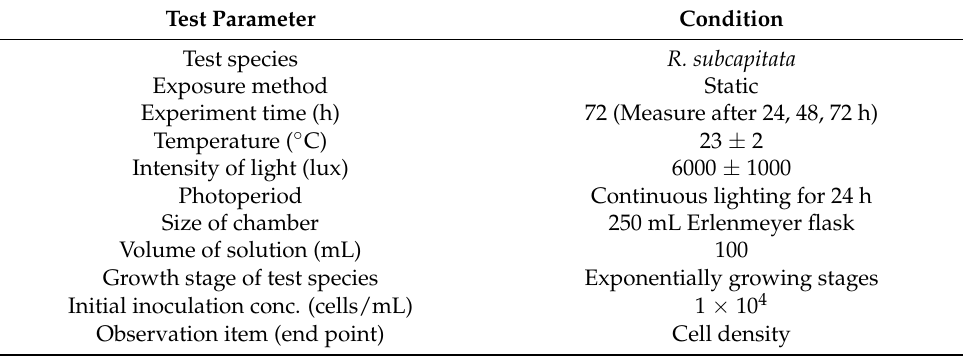
Table 2. Toxicity test conditions using algae (OECD TG 201). Test